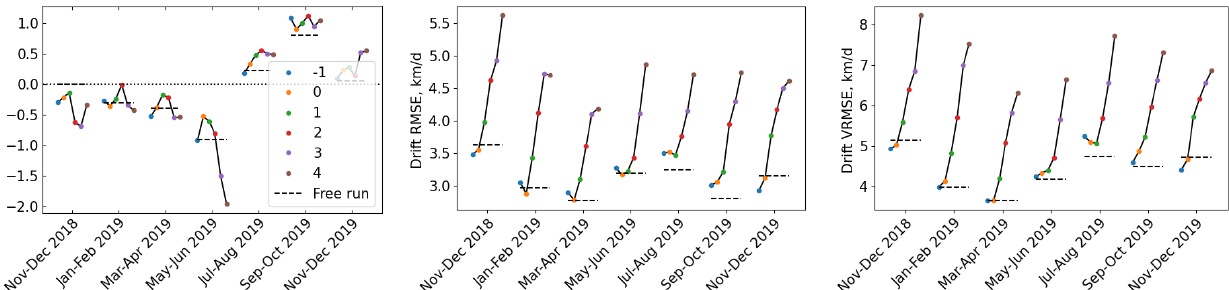
Figure 12. Two-monthly-averaged bias, RMSE and VRMSE for drift grouped by lead time (lead times are indicated in the figure legends). The lead times refer to the start of each 2d drift evaluation period – e.g. “0” covers the period from day 0 (12:00) to day 2 (12:00). The free run errors for the corresponding periods are plotted as dotted lines for reference. The bias is defined as modelled speed minus observed